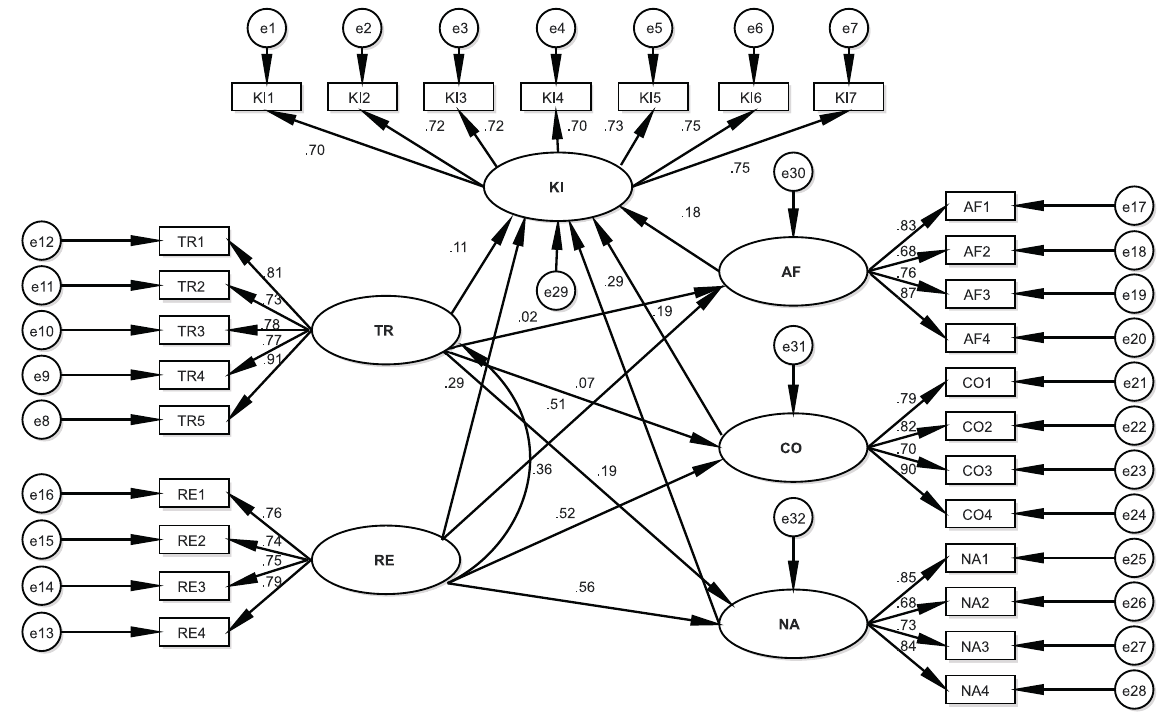
Figure 3. Structural model of the